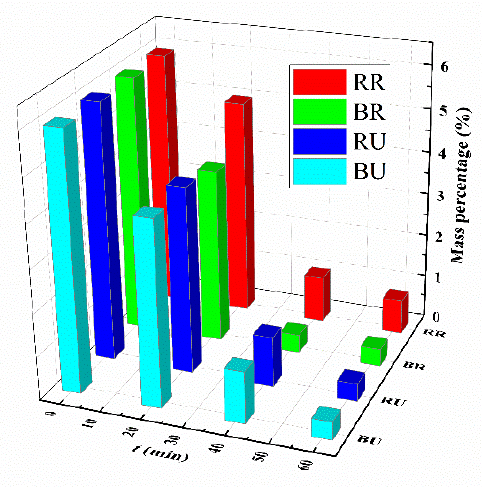
Figure 7. Changes in Na 2 O content in red mud during desulfurization (raw red mud desulfurization (RR), ball mill red mud desulfurization (BR), raw red mud desulfurization under an ultrasonic external field (RU), ball mill red mud desulfurization under ultrasonic external field (BU)).